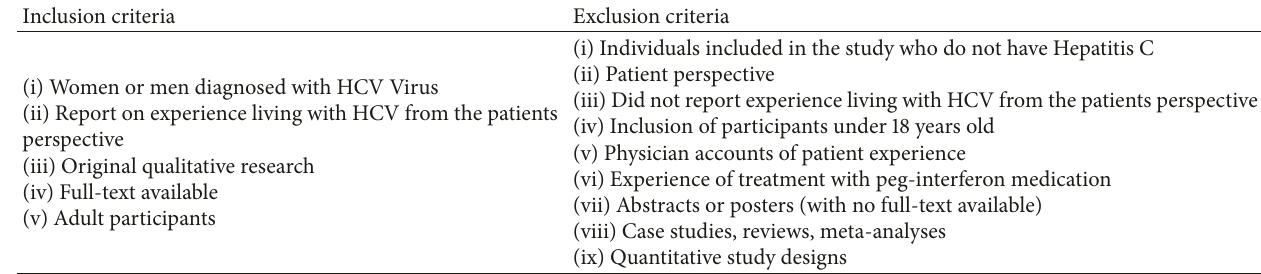
Table 1: Inclusion and exclusion criteria for systematic review of patient experiences with HCV. Inclusion